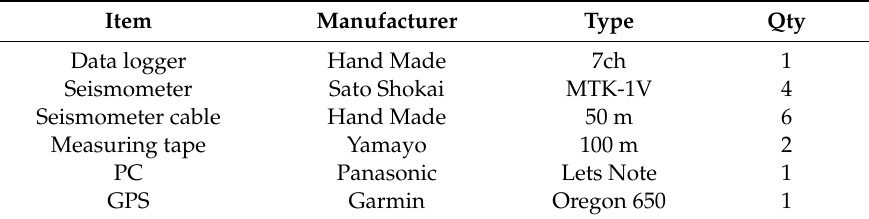
Table 1. Equipment for the microtremor